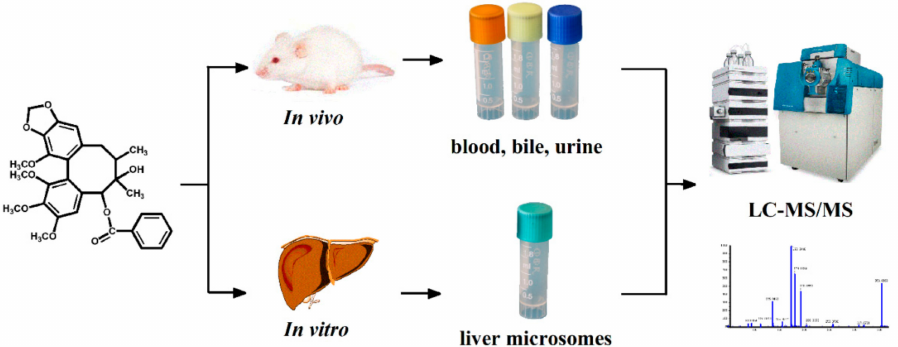
Figure 2. Overview of the experimental